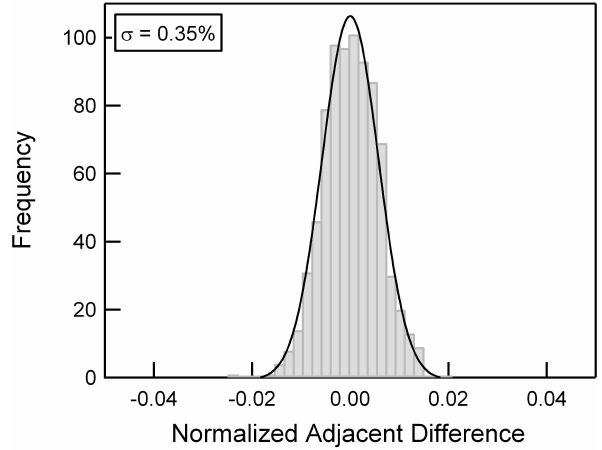
Fig. 6. Distribution of normalized adjacent differences, as measured on a formic acid concentration of 2.3ppbv at 1Hz, yielding an upper limit to the instrument precision (1 σ ) of 0.35% at